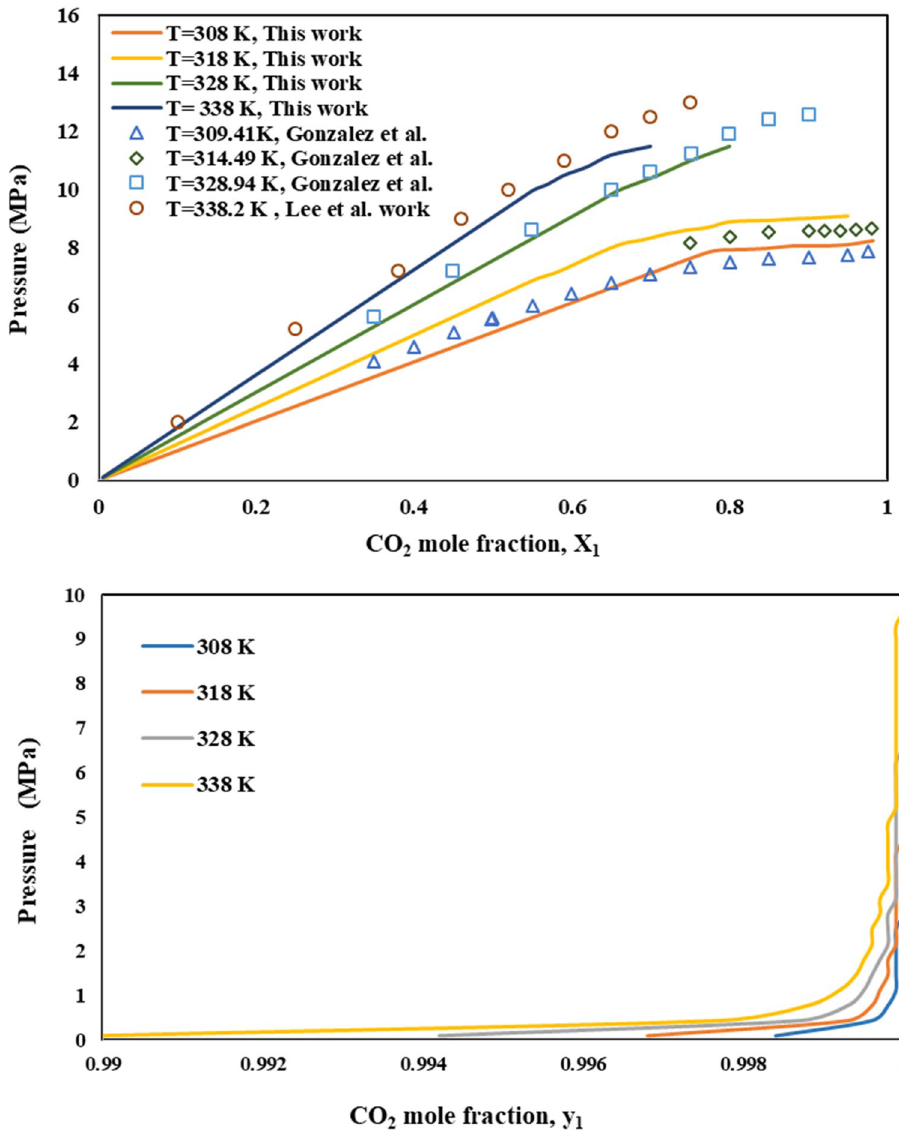
Figure 1. Comparison of VLE of DMSO–CO 2 system calculated according to PR at 308, 318, 328 and 338